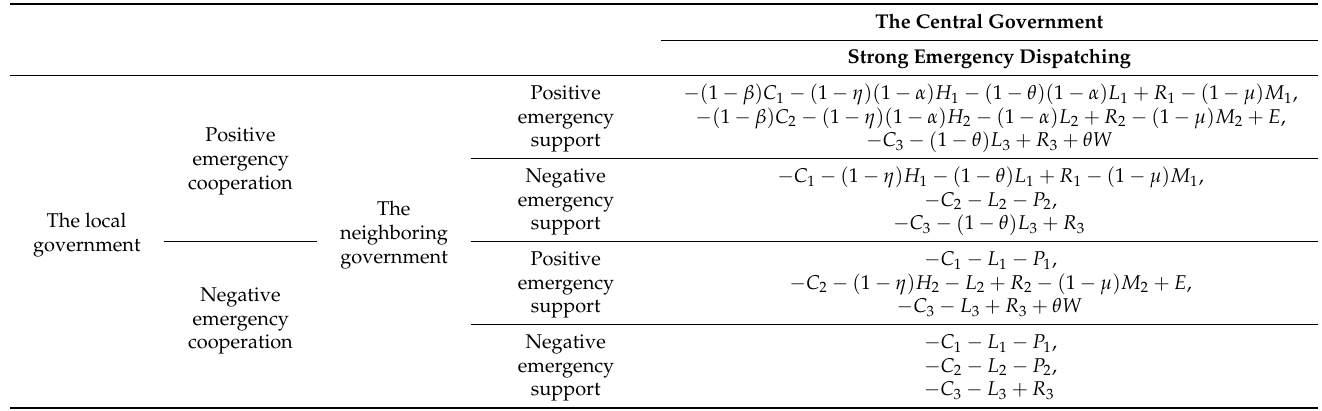
Table 2. The payment matrix under the central government’s strong emergency dispatching strategy.